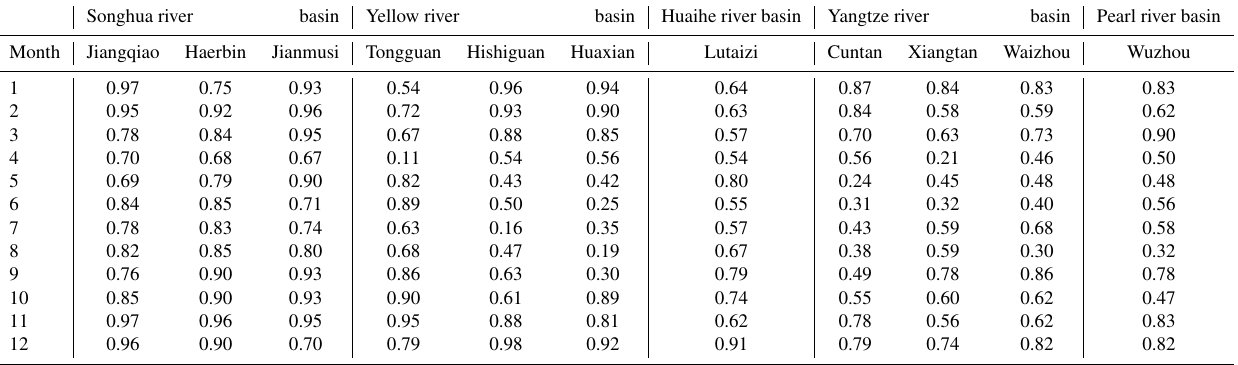
Table 2. Correlation coefficient of the discharge of the end day of the current month and monthly discharge of the next month for major sections in large river basins.